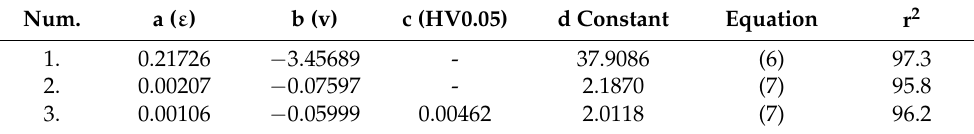
Table 7. Calculated coefficients of regression and coefficients expressing the quality of correlation.